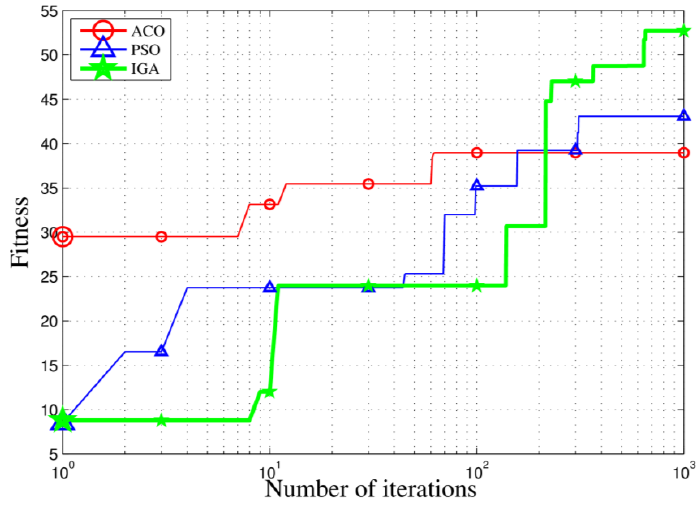
Figure 11. Comparison of different algorithms.